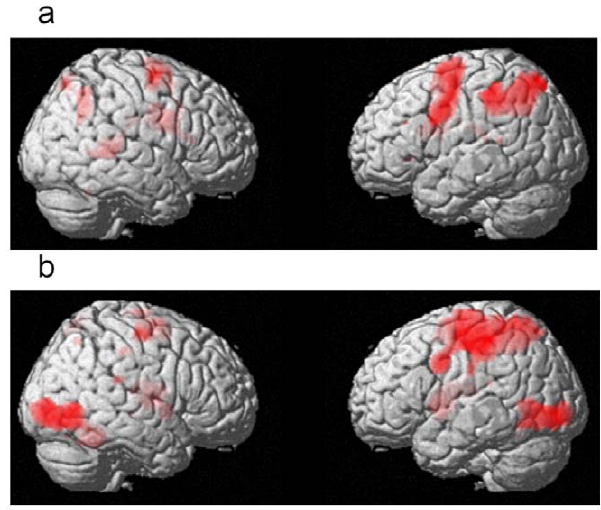
Figure 5. Main effects of task factors on functional activation. (a) Main effect of memory load in the WM task on functional activation. The results are shown with a threshold of P , 0.005, uncorrected for visualization purposes. (b) Main effect of task speed regardless of task nature (non-WM task, WM task). The results are shown with a threshold of P , 0.005, uncorrected for visualization purposes.